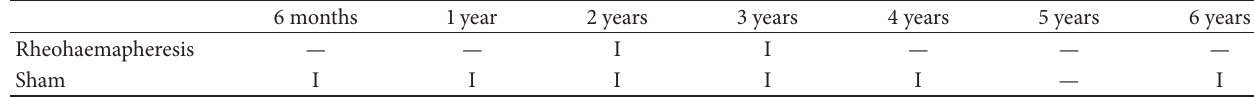
Table 1: The incidence of CNV during the follow up.